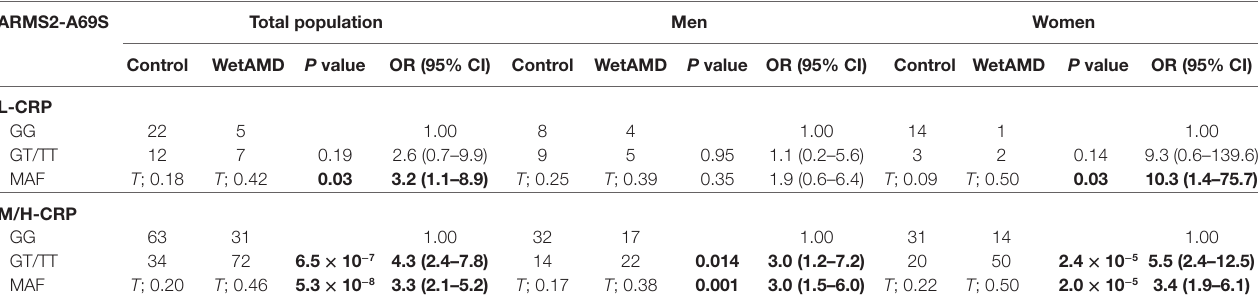
Table 5 | Dominant model of the frequencies observed for the ARMS2 A69S genotype within CRP groups dividing total population, men and women into control and wetAMD groups. arMs2-a69s